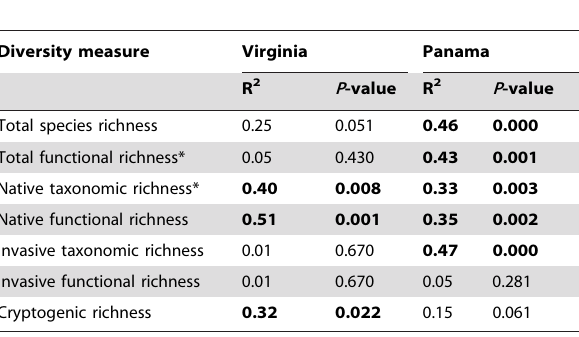
Table 3. Effects of disturbance (independent variable) on diversity (dependent variable) of fouling communities.